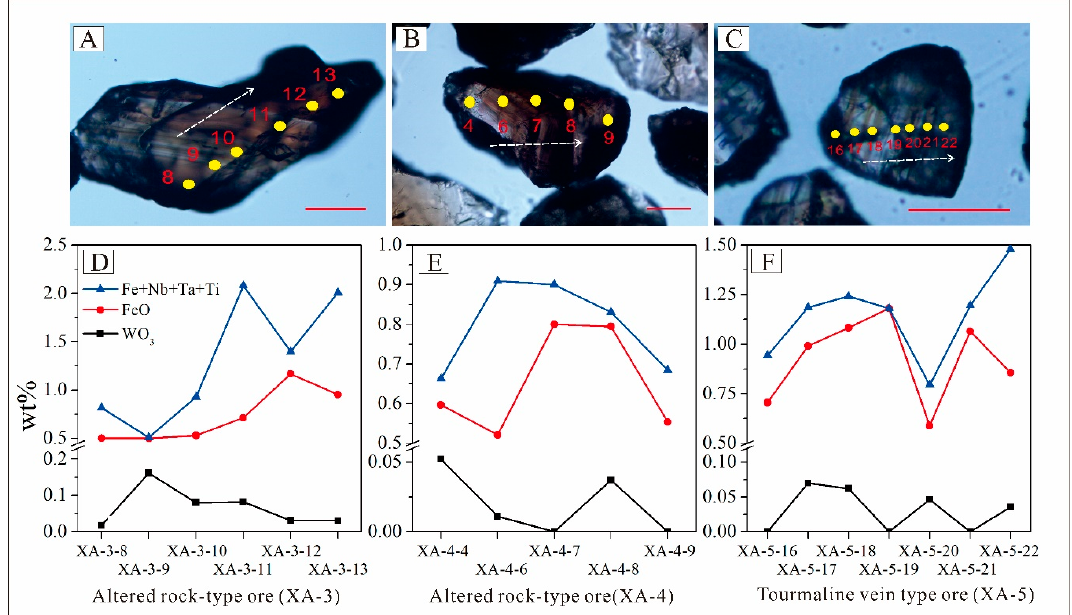
Figure 8. Relations between color and WO 3 , Fe, and Fe + Nb + Ta + Ti contents in di ff erent types of cassiterite samples. ( A , D ) are XA-3; ( B , E ) are XA-4; ( C , F ) are XA-5.